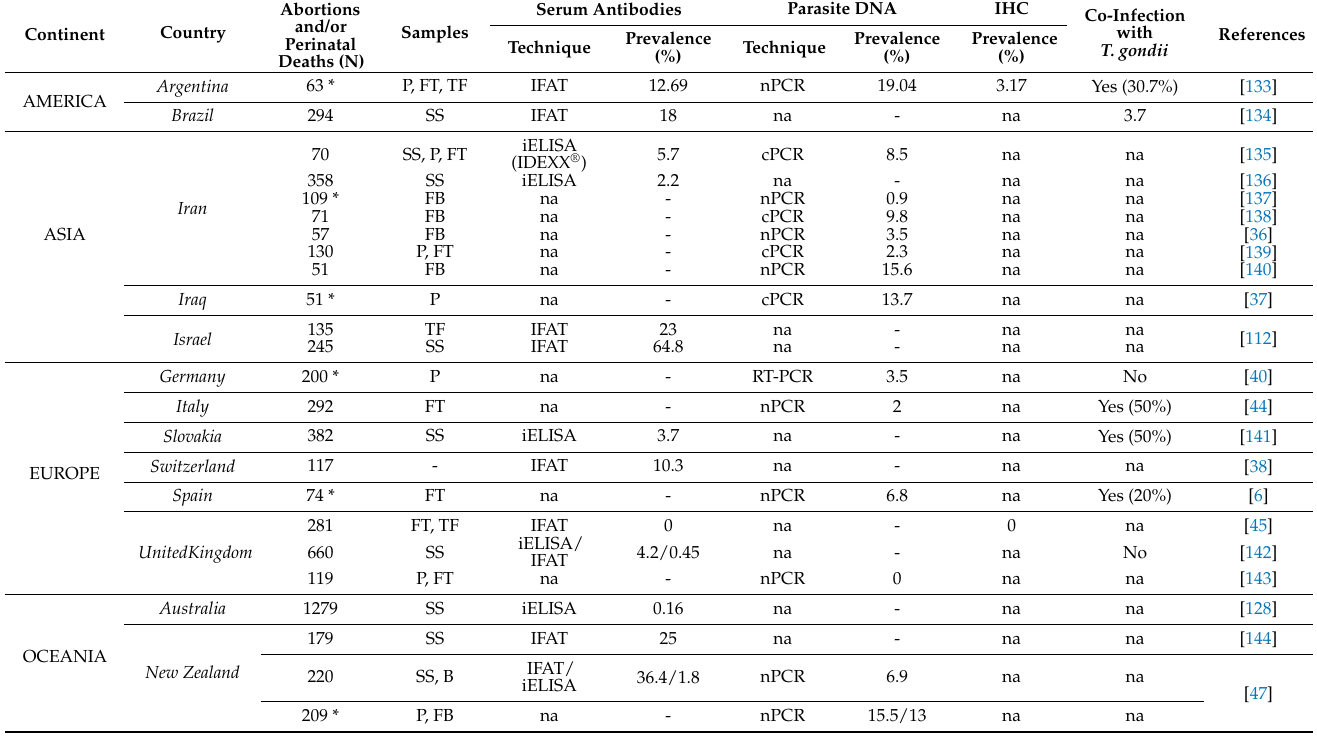
Table 2. Studies conducted worldwide on ovine neosporosis among flocks with reproductive failure.